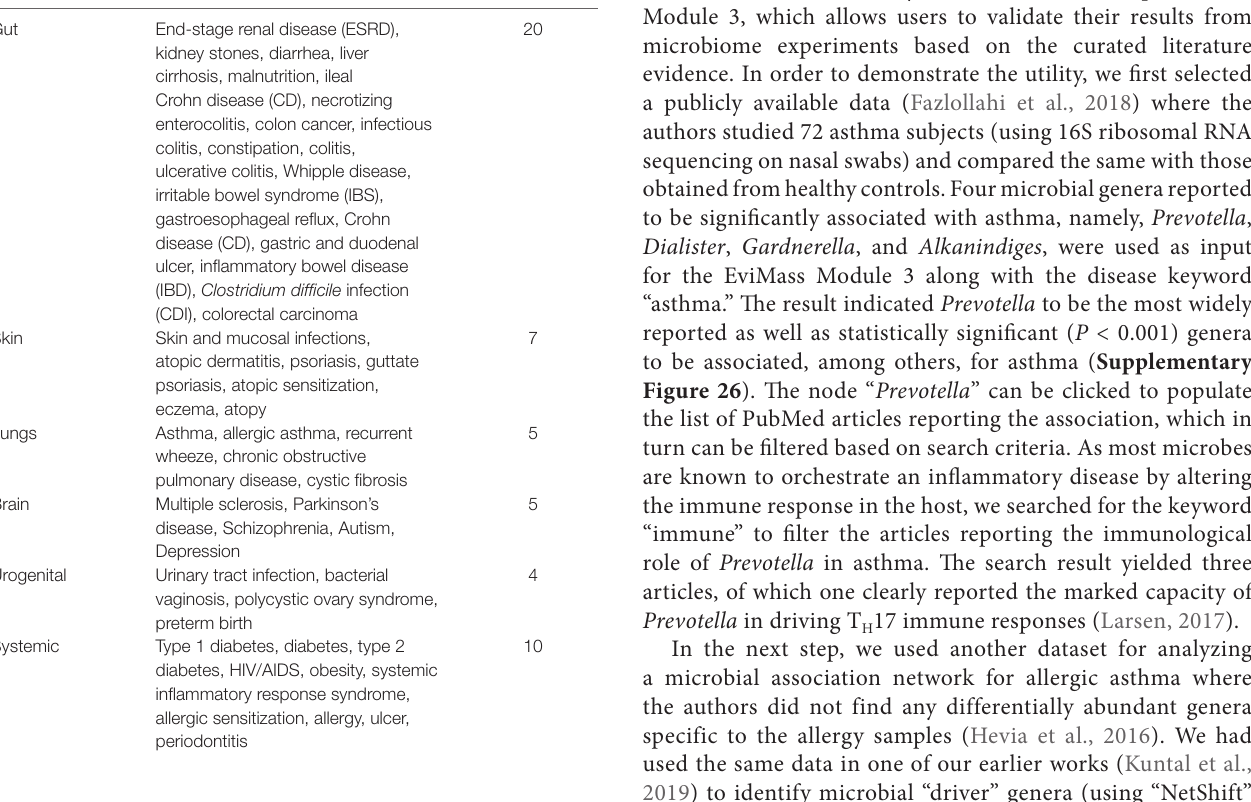
TABLE 1 | List of different microbe-related human diseases categorized by the organs they affect. Organs